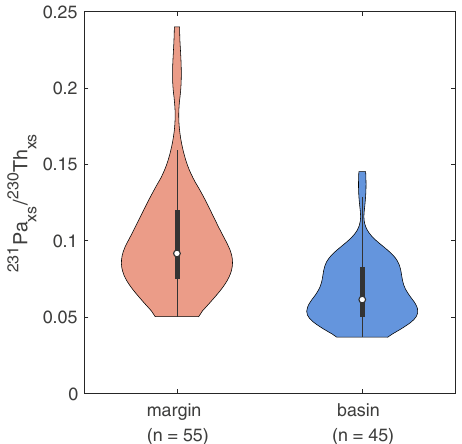
Fig. 3 Violin plot of excess 231 Pa/ 230 Th ratios in margin samples (orange) and basin samples (blue). The shape of each plot represents the kernel density estimation, the white dot represents the median, the thick black bar represents the interquartile range, and the thin black line represents the upper and lower adjacent values (±1.5 interquartile range). Wider sections of the plot indicate a higher probability that a data point in the group will have that value, while narrow sections indicate a low probability that the data in the group falls in that